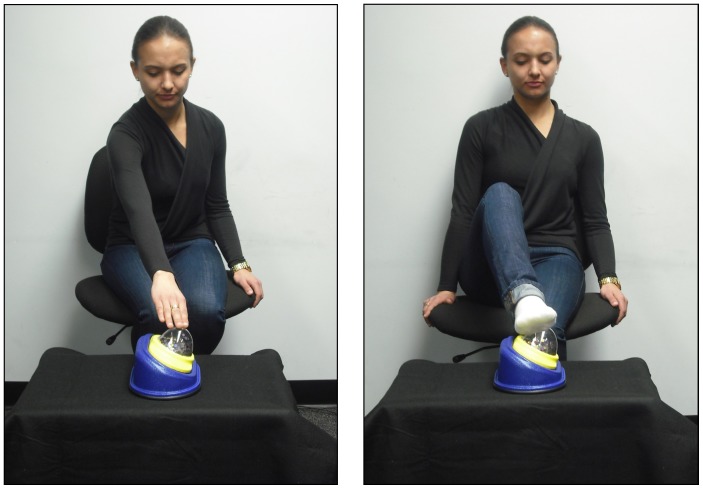
Experimental stimuli.These photographs show the experimental setup for the Observe-Hand and Observe-Foot groups. The actor in the photograph has given written informed consent, as outlined in the PLOS consent form, to publication of their photograph.